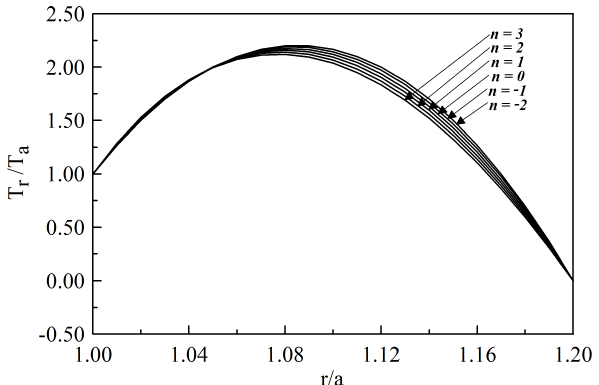
Figure 21: Radially distributed temperature